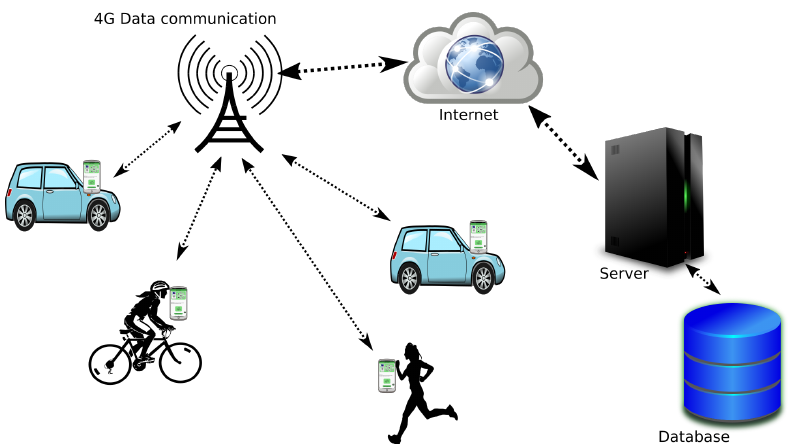
Figure 1. System architecture. Vehicles are connected to the cloud server through smartphones and the 4G cellular